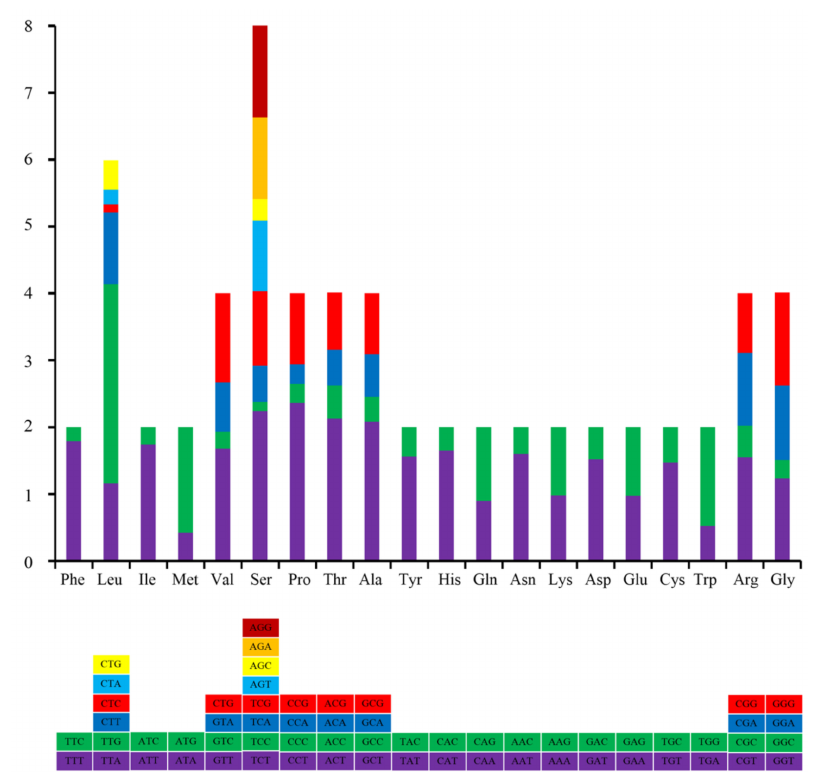
Figure 2. Relative synonymous codon usage (RSCU) of mitochondrial genome for Hyotissa hyotis